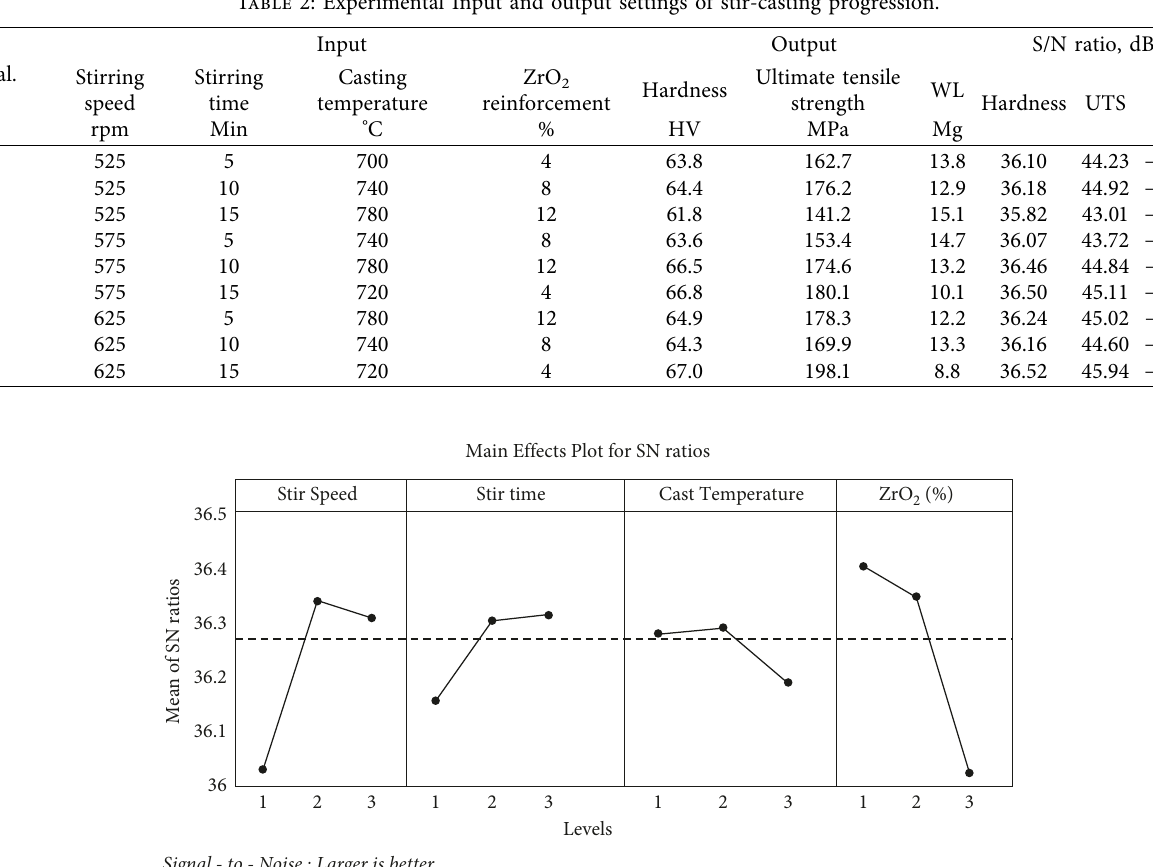
Figure 2: Main effect plot for